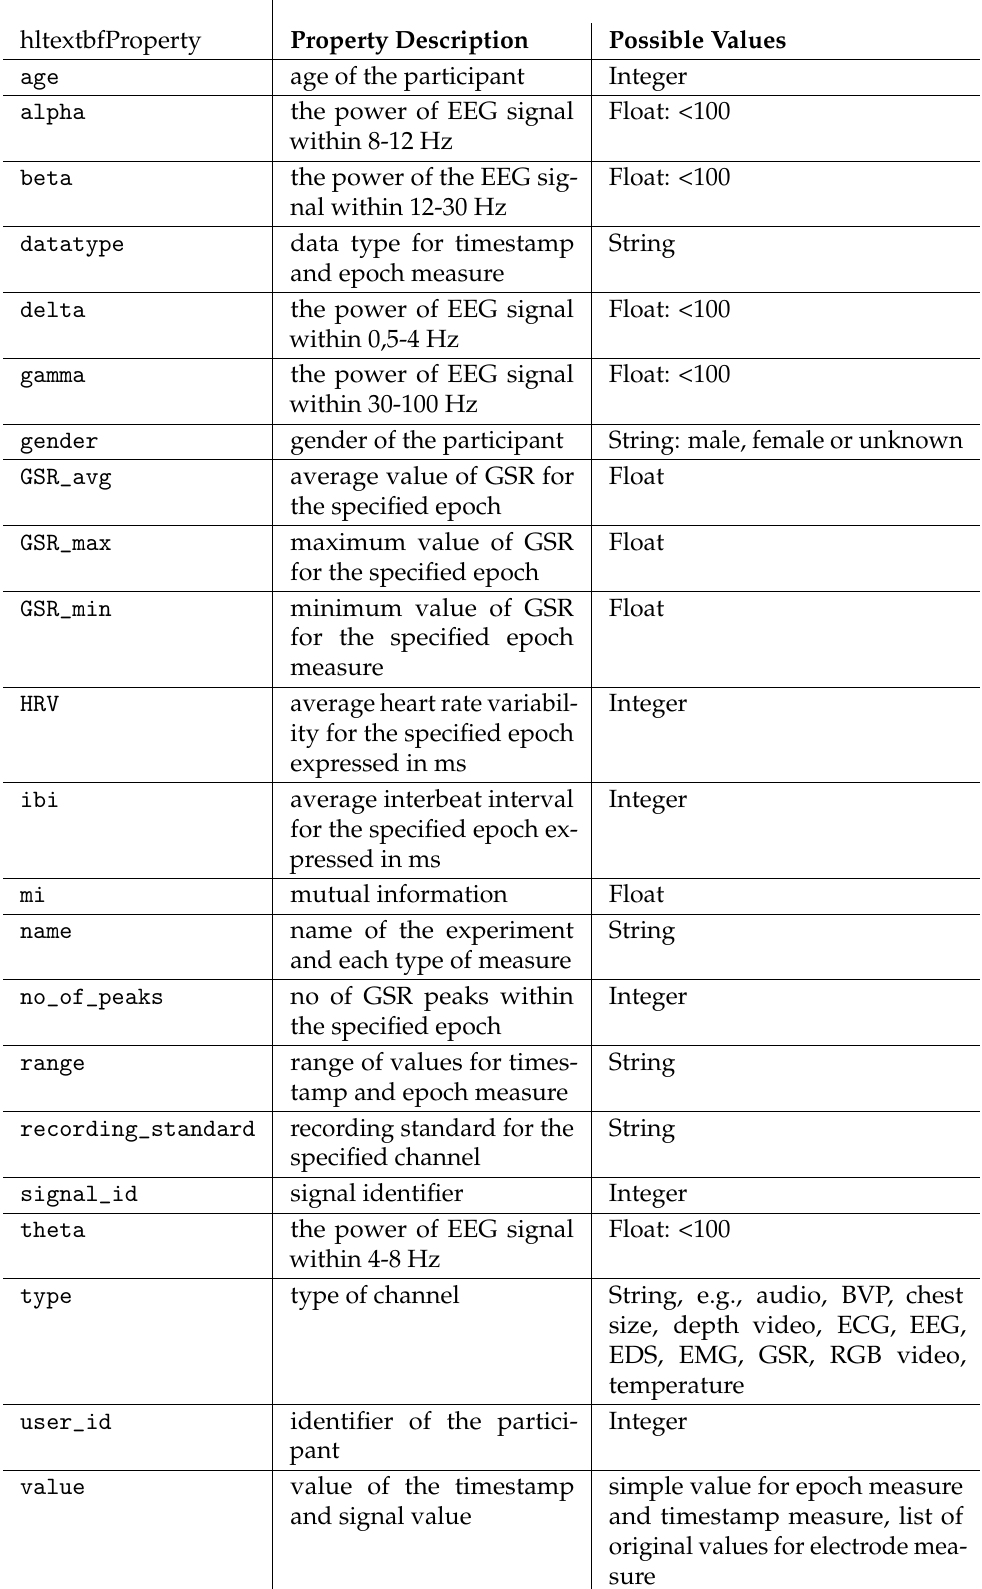
Table A3. The settled subset of Prop